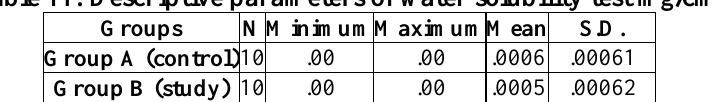
Table 11: Descriptive parameters of water solubility test mg/cm 2